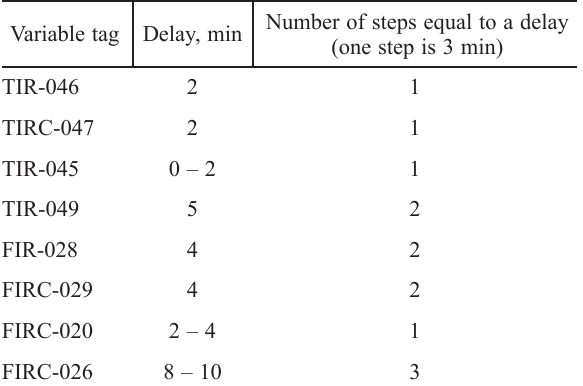
Table 3 – 2-MP content value time delays in regards to the Table 2 – 2,3-DMB content value time delays in regards to change in the value of each input variable the change in the value of each input variable Number of steps equal to a delay Number of steps equal to a delay Variable tag Delay, min Variable tag Delay, min (one step is 3 min) (one step is 3